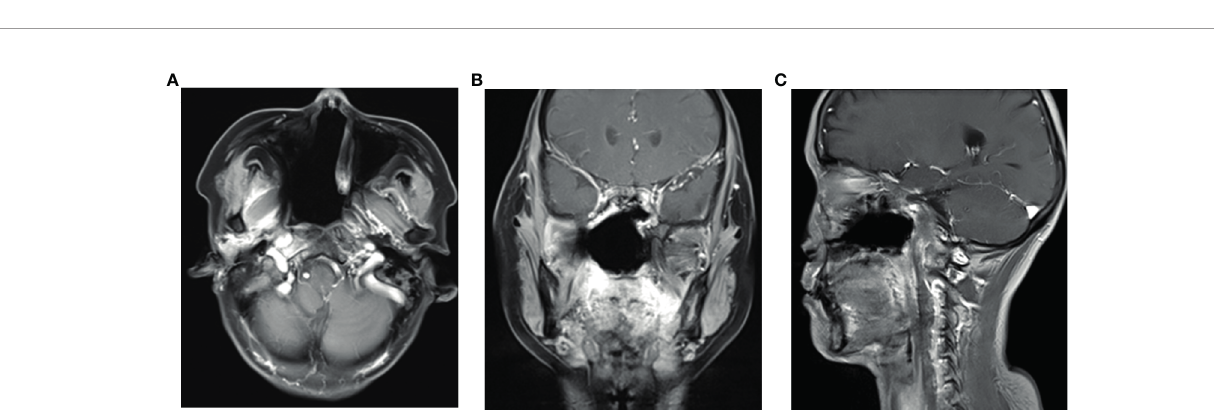
FIGURE 3 | After three cycles of anlotinib treatment, the August 2019 contrast enhancement T1-weighted MR imaging showed the primary tumor was signi fi cantly reduced (A – C)